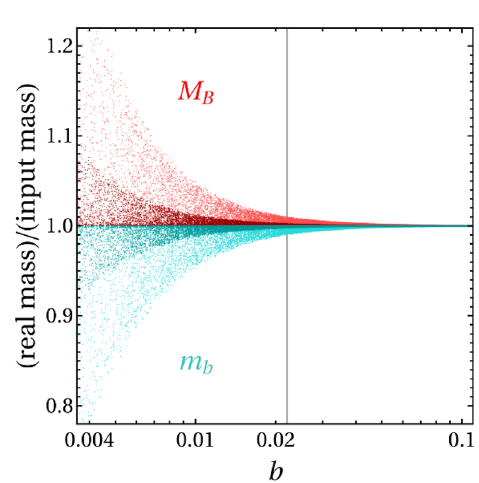
Figure 1 . Distribution of ( a; b ) for b 2 [0 ; 1 = a 2 + b 2 = 1. The red dashed line represents b = 1 =